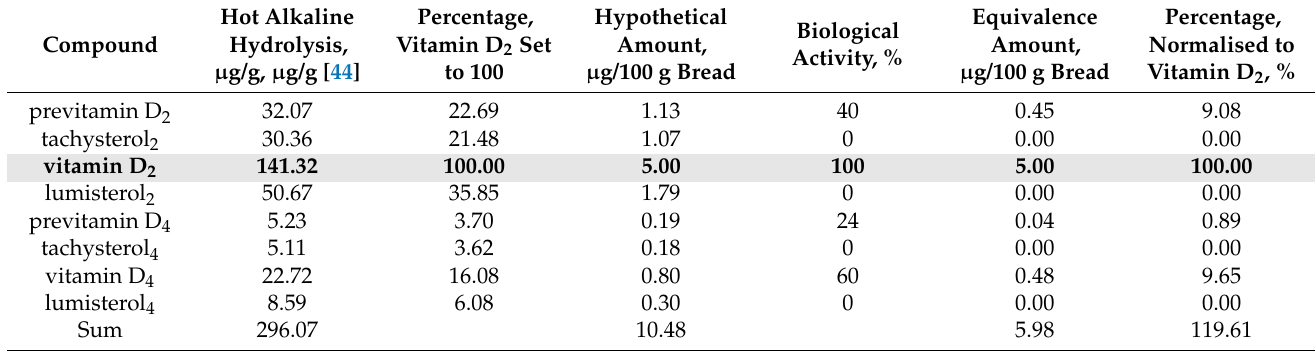
Table 3. Yield from hot alkaline hydrolysis of oyster mushrooms after UV irradiation, determined by HPLC. The yields for the different identified vitamin D isomers as well as precursors and photoinduced side products are provided, as well as the percentage of each compound normalised to the identified vitamin D 2 amount. The hypothetical amounts of all the precursors and photoinduced side products in vitamin D 2 -fortified bread based on an amount of 5 µ g per 100 g bread is